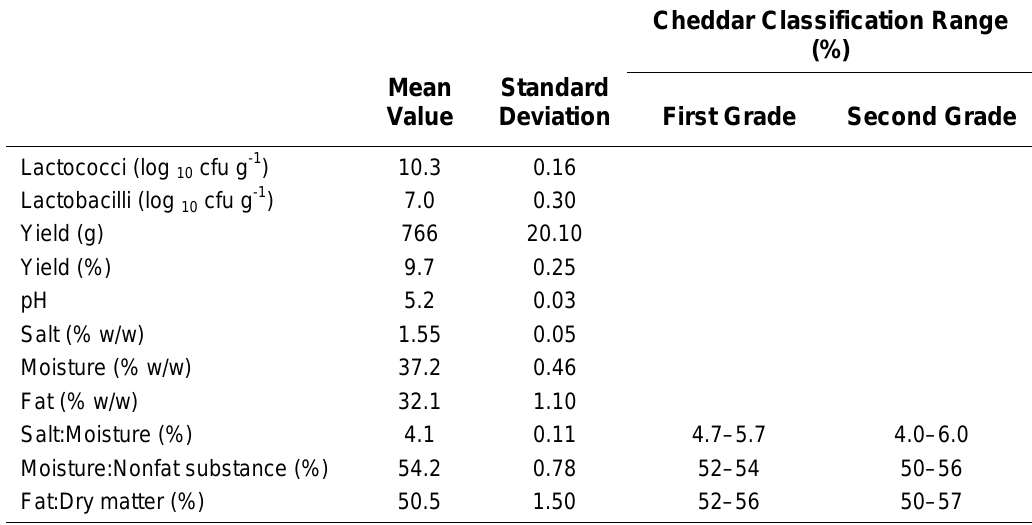
Survival of M. avium subsp. paratuberculosis During the Manufacture of Cheddar Cheese . Map Count log